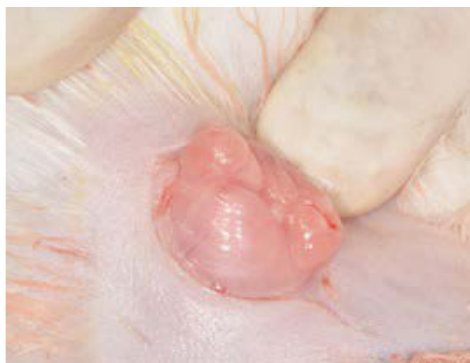
Figure 1. Incision and exposure for the removal of adipose tissue from animal’s dorsal